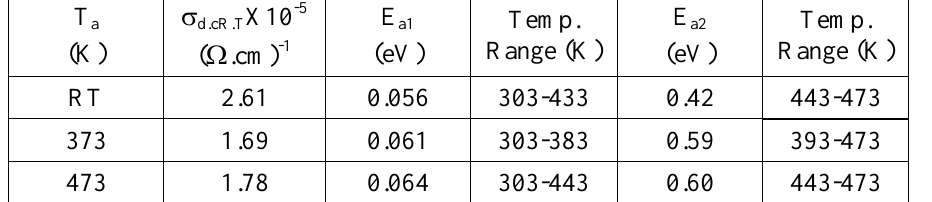
Fig.5: ln  versus 10 3 /T for ZnO films at different annealing temperatures. Table 4: D. C. conductivity parameters for ZnO films at different annealing temperature.